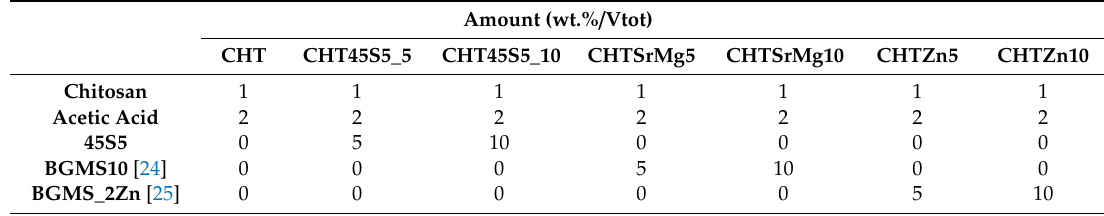
Table 2. Amount of materials and sample